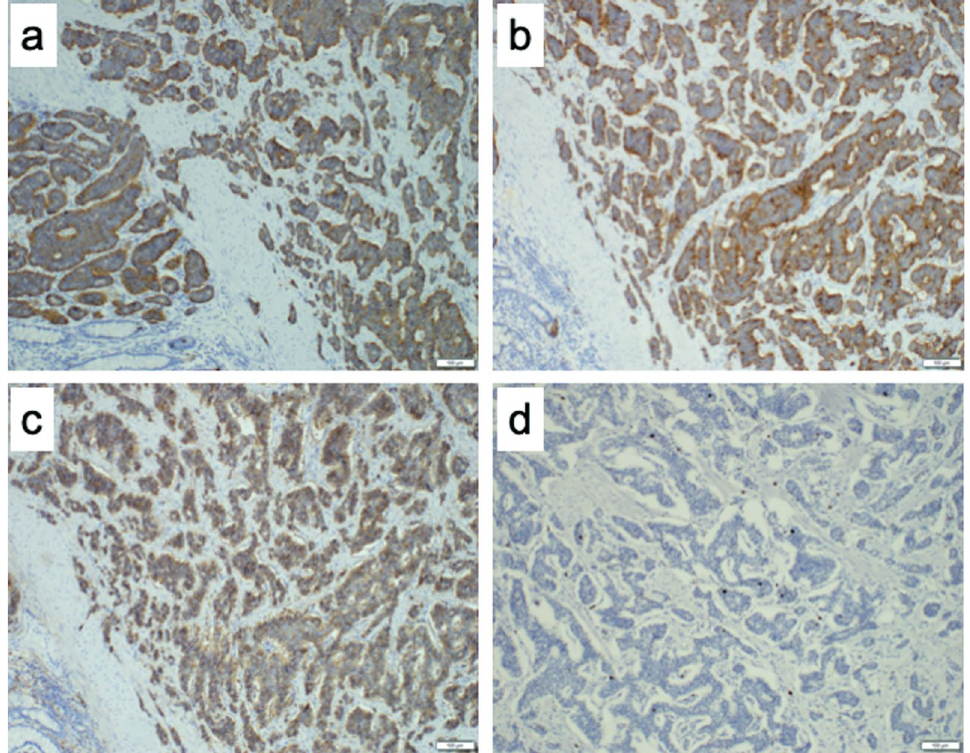
Fig. 5 Immunohistochemistry findings of excised specimen. a Chromogranin A (